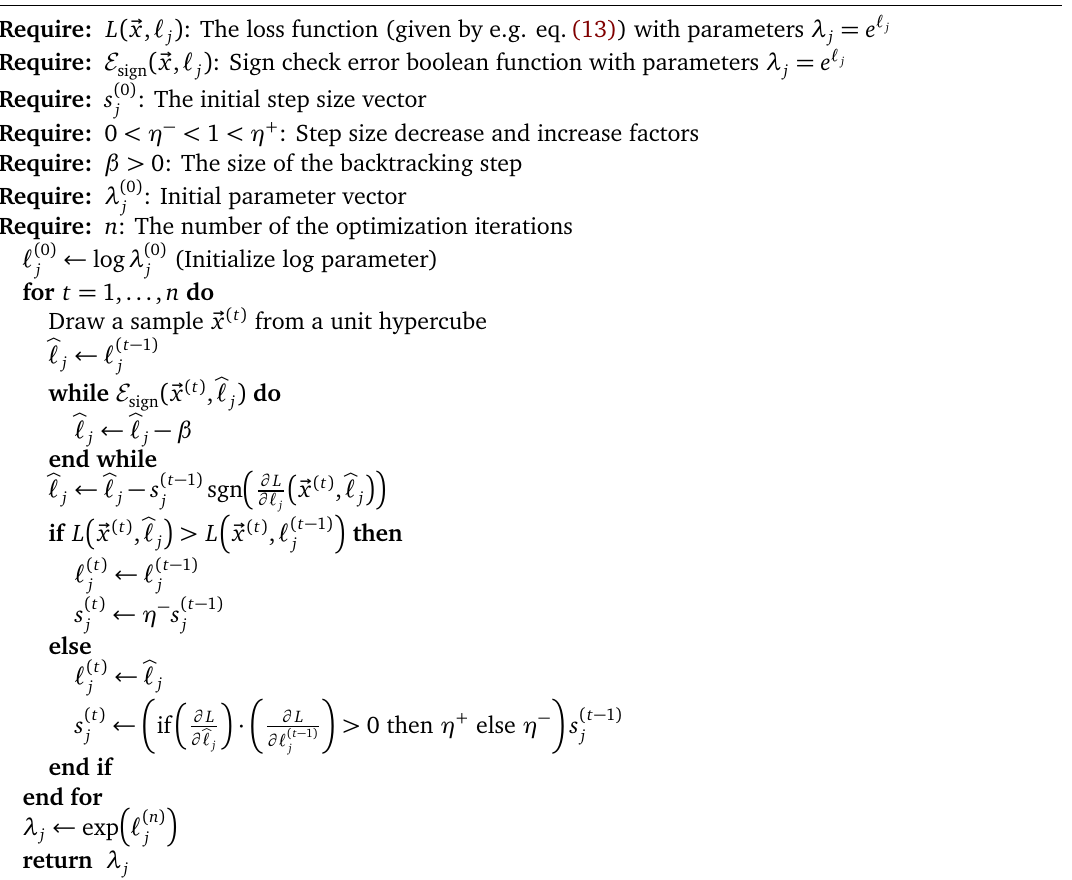
Algorithm 1 The Λ -glob algorithm for the global lambda optimization. Good default settings ( 0 ) for the tested examples were λ